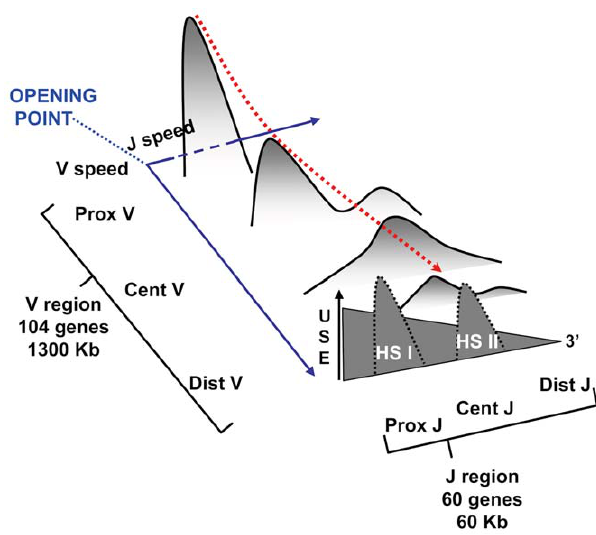
Figure 7. Schematic representation of the TRA/TRD locus use. The scheme shows the rearrangement distribution of 4 V genes with all J genes. The dashed red arrow indicates the decreasing frequency of rearrangements which correlates with the associations of distal V and J genes. A distal V gene is very rarely rearranged with proximal J genes because of the high recombination frequency between proximal V and J genes, leading to the proximal J genes deletion. 1) the first step governing the TRA/TRD locus utilization is defined by the opening of the most proximal V-J region, 2) According that T cells can undergo 1 to 3 secondary rearrangements, the second step giving the V and J accessible windows, is defined by the opening speeds of V and J regions. V speed is about 18 Kb/h whereas J speed is about 1 Kb/h, 3) J region has two Hot Spots of rearrangement. HSI is centred on J48 and HSII is centred on